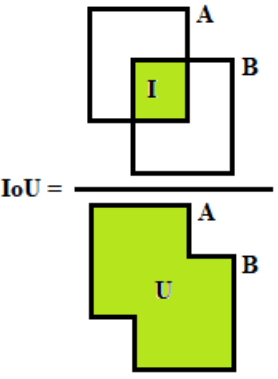
Figure 6. Intersection over union illustration.